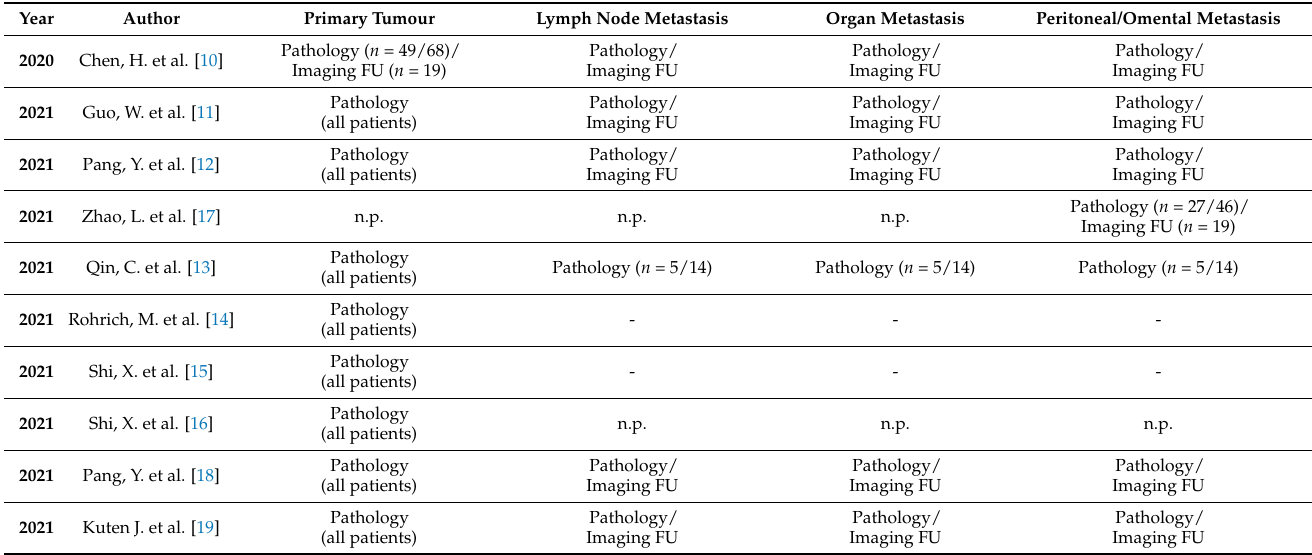
Table 3. Reported reference standards to confirm malignant nature of